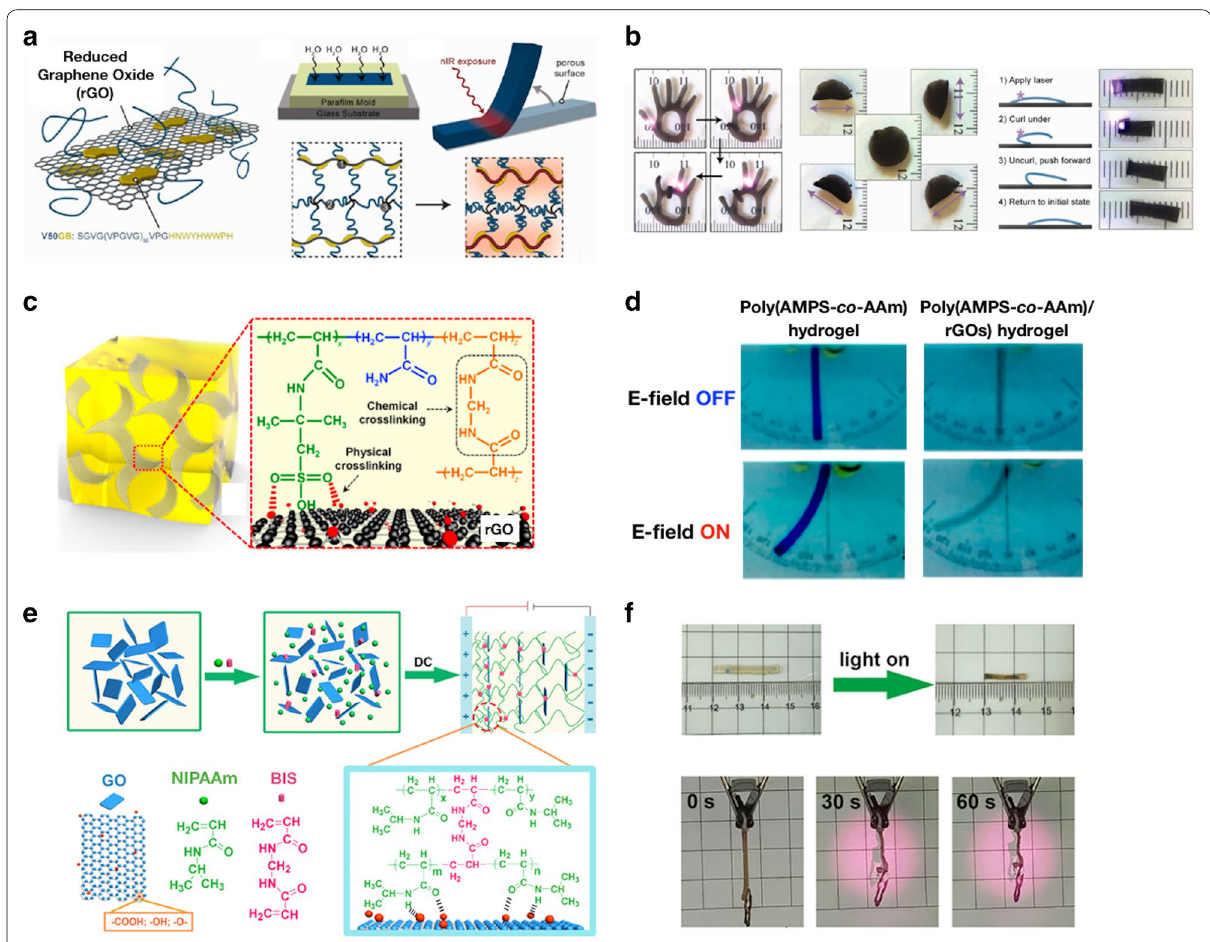
Fig. 7 a Scheme of the synthesis of the V50 GB functionalized rGO based hydrogel. b Various actuations of the rGO hydrogel actuator via NIR light exposure such as light-driven bending and unbending of fingers, raster direction-dependent folding, and crawling. ( a , b were reproduced with permission from Ref. [57], © 2013, American Chemical Society). c Schematic of the poly(AMPS-co-AAm)/rGO composite hydrogels. d Images of the poly(AMPS-co-AAm)/rGO hydrogel actuation with electric field of 10 V. ( c , d were reproduced with permission from Ref. [58], © 2017, American Chemical Society). e Schematic images of the synthetic process to prepare the hydrogel containing gradually oriented GOs via the DC electric field. f Photographs of the NIR light-responsive hydrogel actuator before- and after irradiation for 50 s (top). The images demonstrate the lifting cargo of the hydrogel after NIR irradiation for 60 s (bottom). (e and f were reproduced with permission from Ref. [59], © 2018, American Chemical